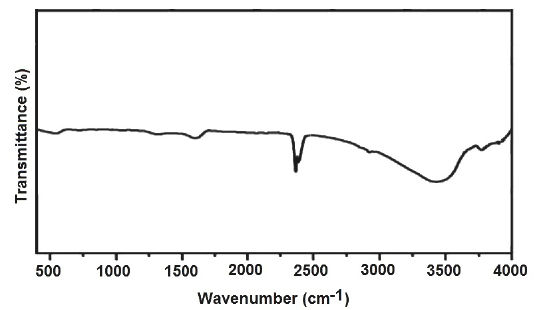
Fig.2. FT-IR spectrum of cerium oxide nanoparticles